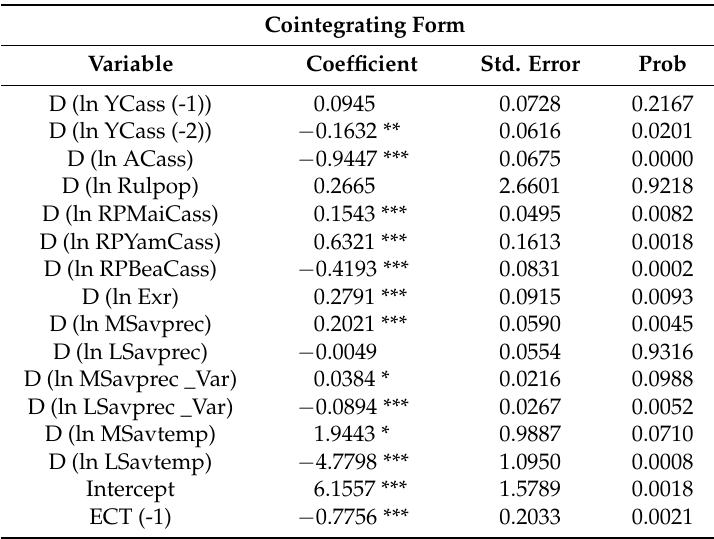
Table 3. ARDL Cointegrating and long-term estimates. (Original dep. Variable: ln YCass;